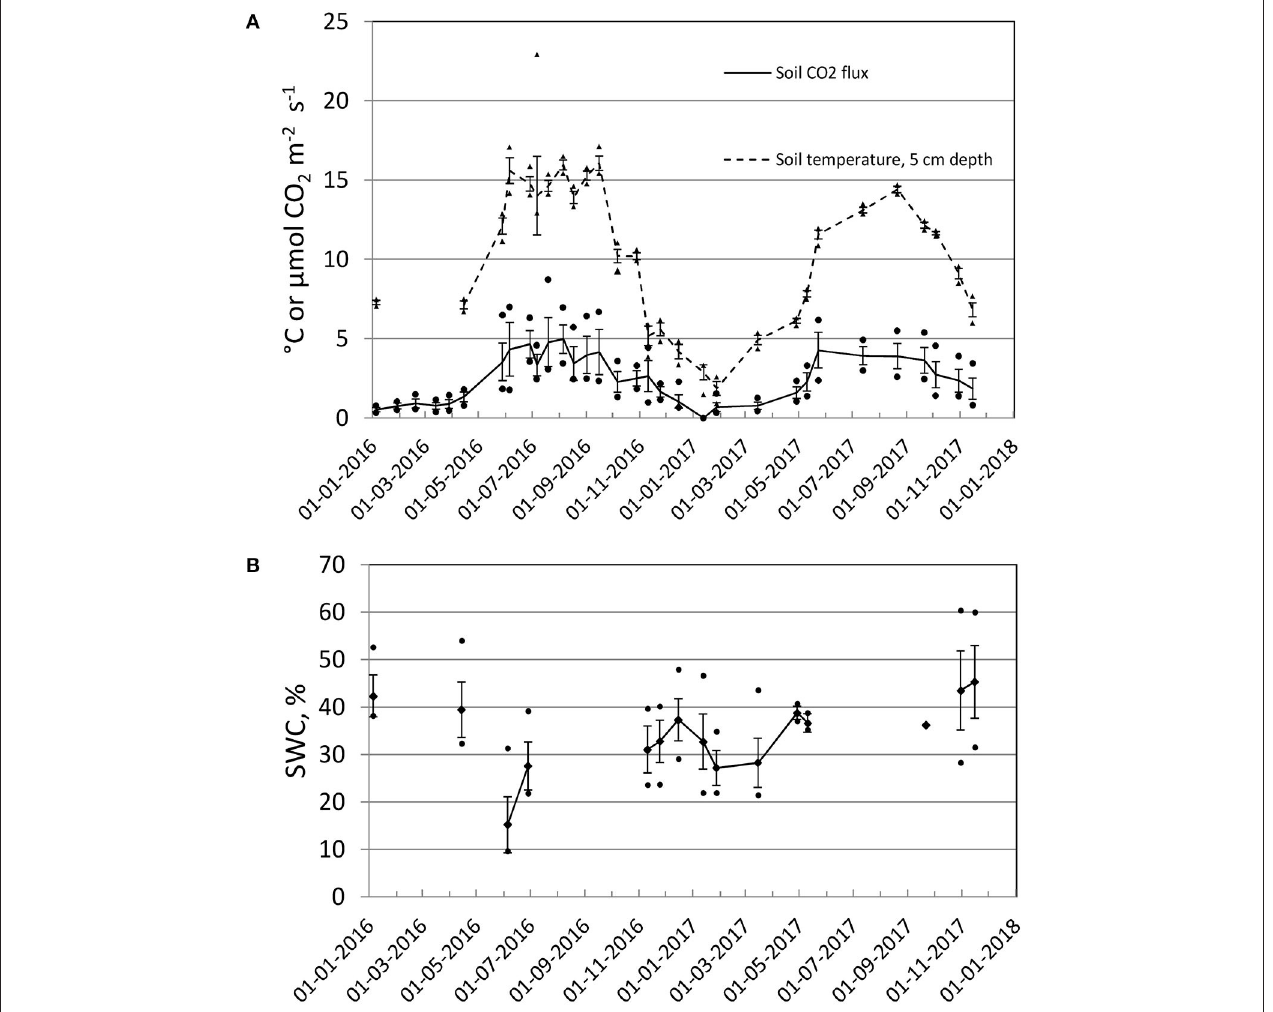
FIGURE 3 | (A) Soil temperature (triangle) and soil respiration (dot) measured at 2–4 week intervals during 2016 and 2017, (B) Volumetric (%) soil water content (SWC) in topsoil (0–5cm) during 2016 and 2017. The overall mean was 34.3% with a range of 9.7–60.4%.